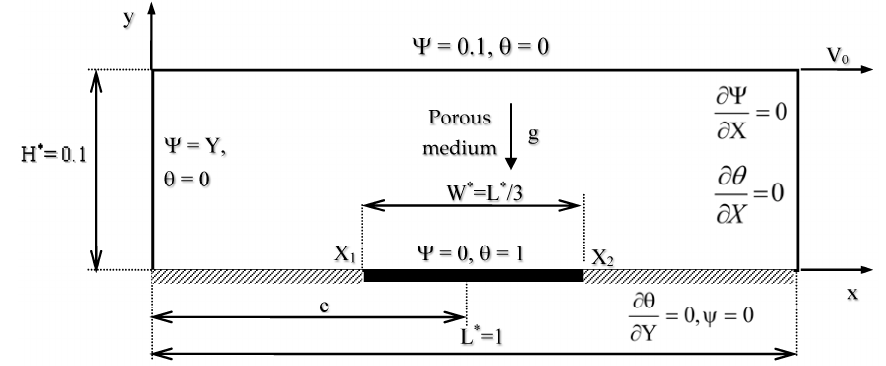
Figure 1 Schematic configuration with coordinates and boundary conditions Figure 1. Schematic configuration with coordinates and boundary